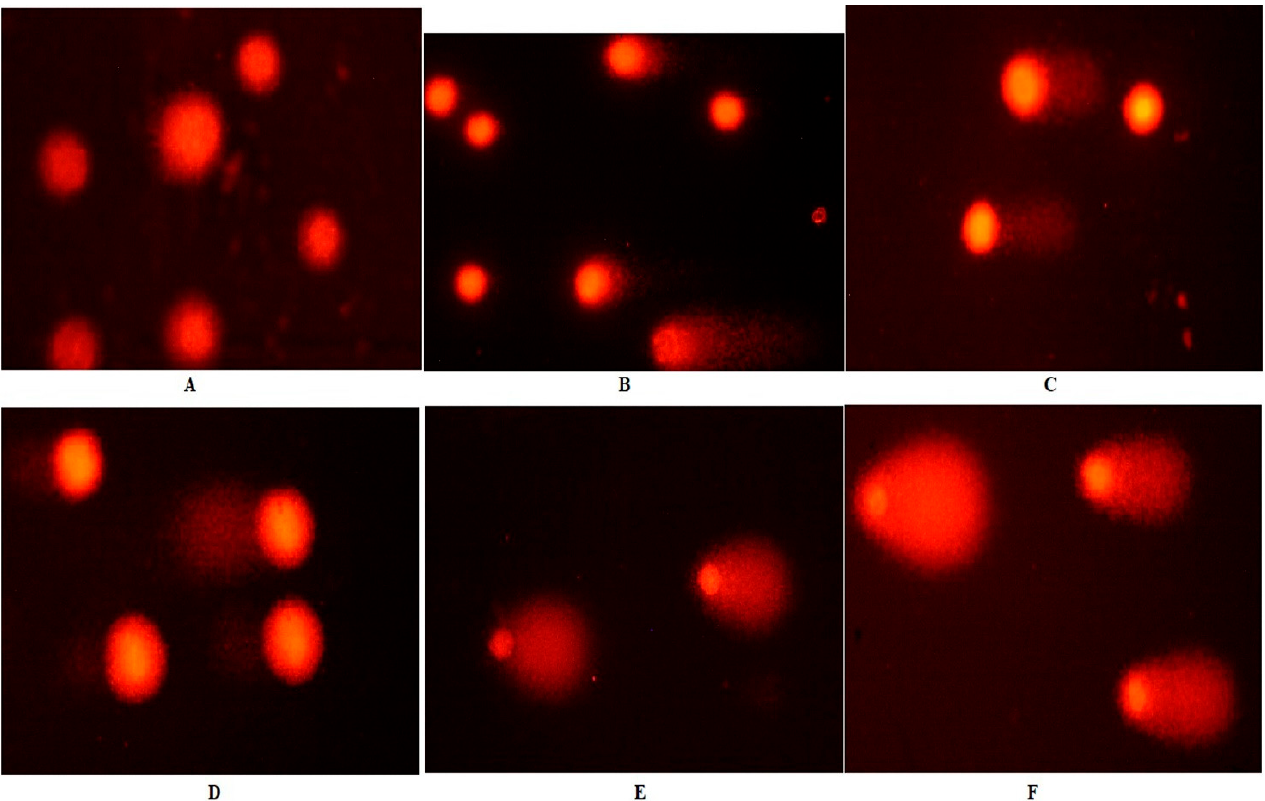
Figure 3. Sample images from the comet assay. ( A ) Growth control; ( B ) IC12.5; ( C ) I C25; ( D ) IC50; ( E ) IC75; ( F ) positive control (200 μ M H 2 O 2 ). DNA double ‐ strand breaks effects of Fe ‐ Ni ANPs were evaluated with a γ H2AX kit. The amount of activated γ H2AX determined is proportional to the DNA double ‐ strand breaks (DSB). The percentage of cells containing activated γ H2AX at IC75 concentration